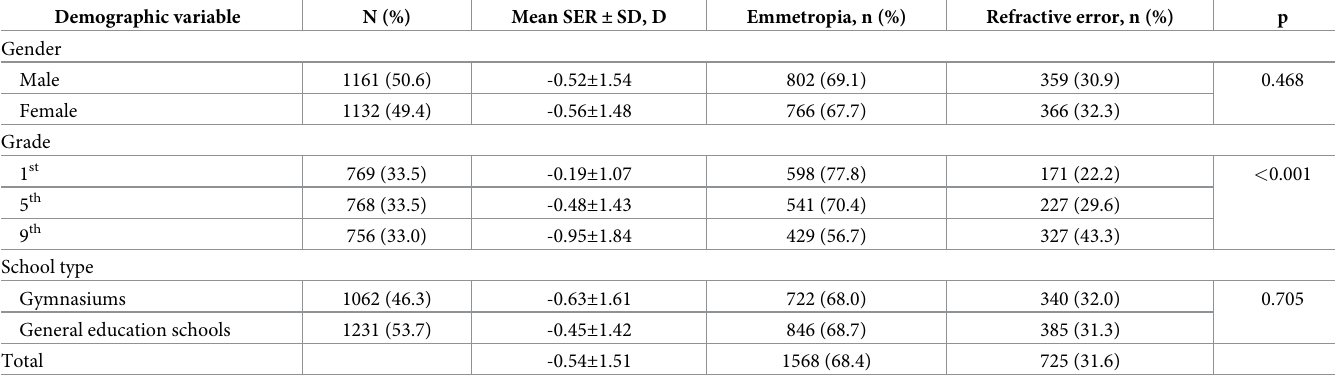
Table 1. The characteristics of sample and prevalence of refractive errors (N =